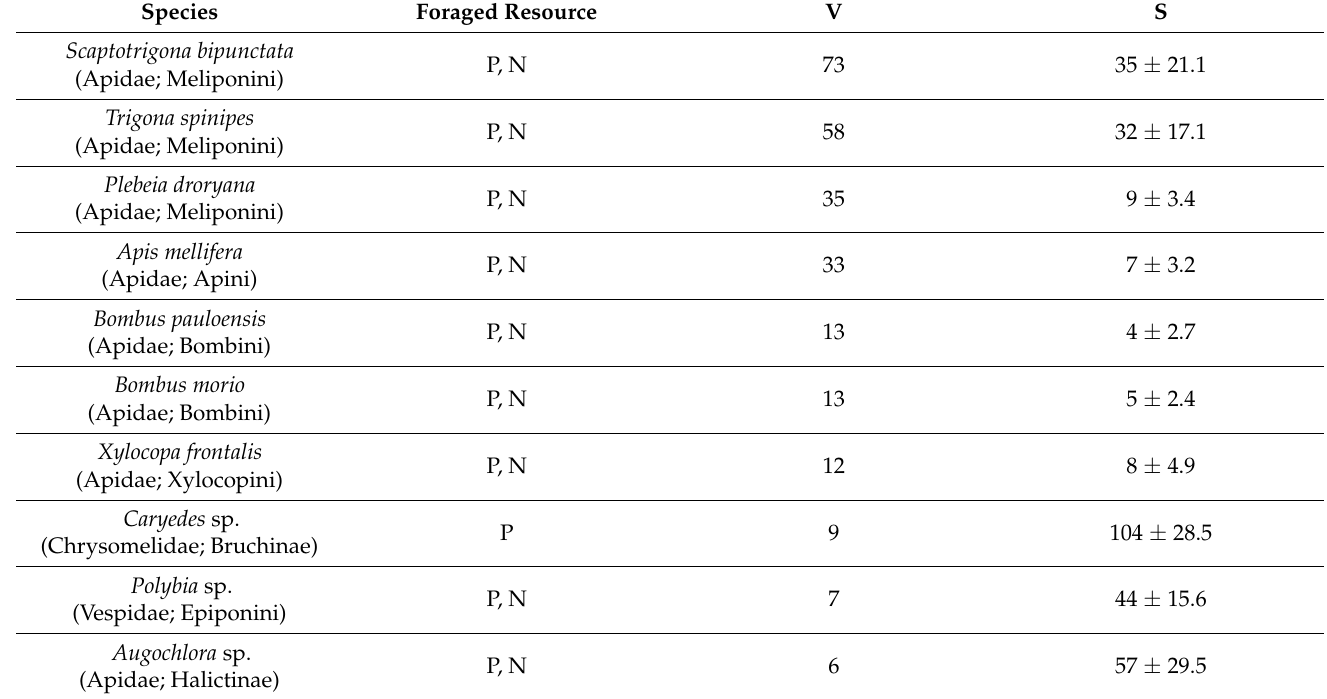
Table 2. Frequency of pollinators in Pereskia aculeata . V = number of visits. S = average time of visits (in seconds) and standard deviation. P = pollen. N =